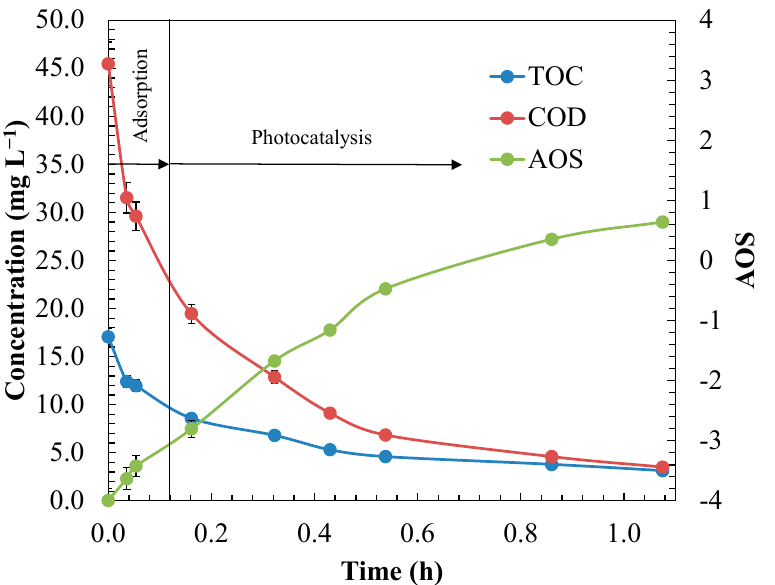
Figure 14. Evolution of the average oxidation state (AOS) and chemical oxygen demand (COD) during photocatalysis of ANI and BTH. Experimental conditions: C 0 = 12.0 mg L − 1 ; pH = 9.0; m CAT = 0.9 g L − 1 ; Irradiation dose = 155.8 W m − 2 ; T = 26 °C.